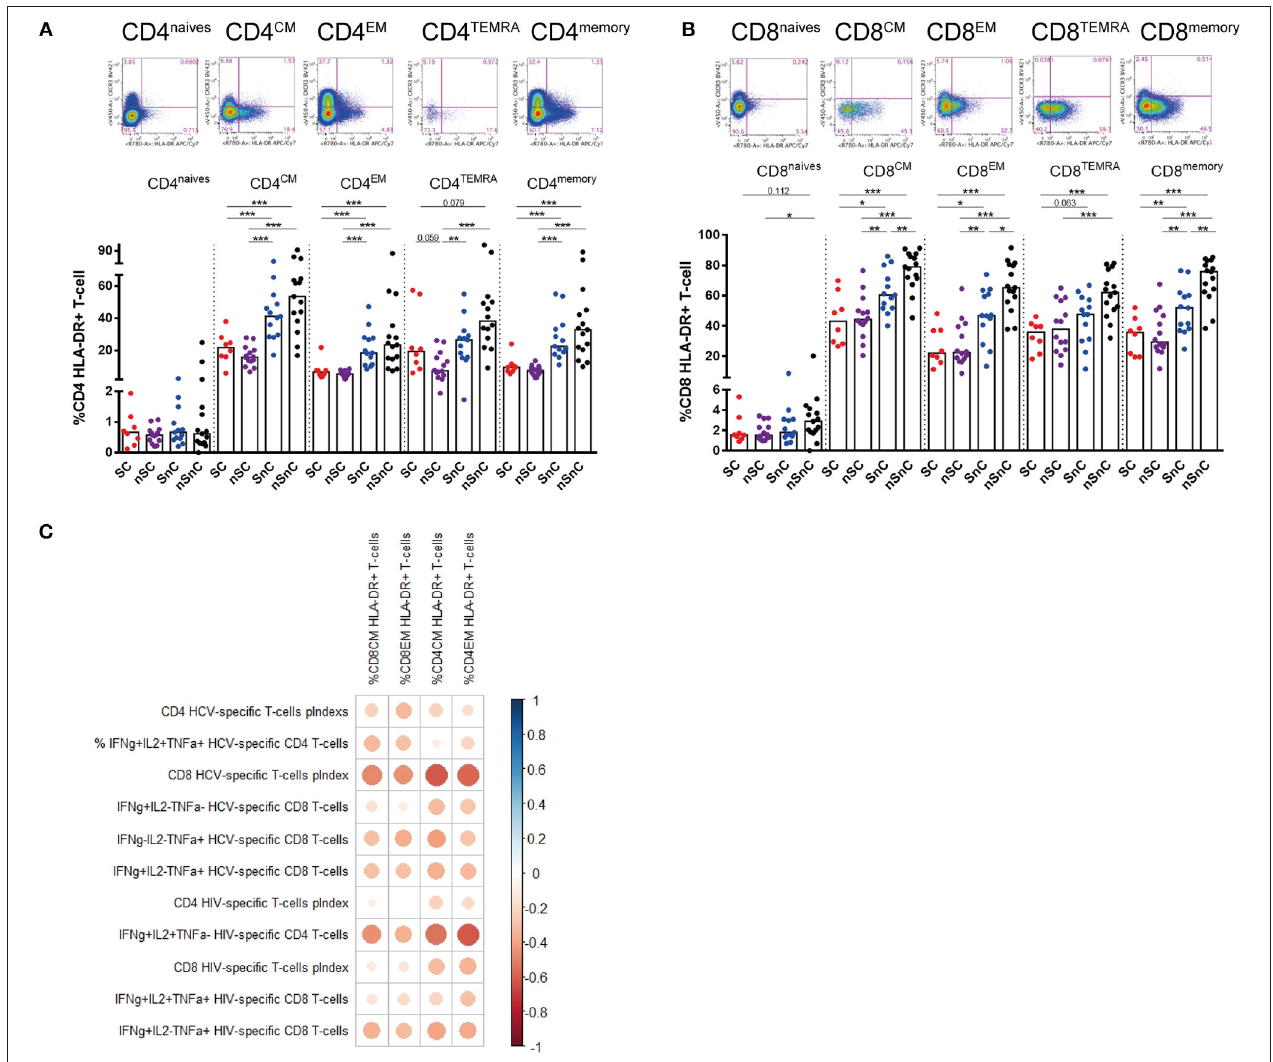
FIGURE 3 | T-cell activation. (A) Frequency of CD4 T-cell subsets expressing HLA-DR. Mann–Whitney U -tests was used to assess diferencies between groups. (B) Frequency of CD8 T-cell subsets expressing HLA-DR. Mann–Whitney U -tests was used to assess diferencies between groups. (C) Pearson correlation between CD4 and CD8 expressing HLA-DR and HCV- and HIV-specific T-cell responses. mem, memory total; CM, central memory; EM, effector memory; TEMRA, terminally differenciated. SC, supercontrollers, HCV spontaneous clearers and HIV-elite controllers; nSC, non-spontaneously HCV clearers HIV-elite controllers; SnC,